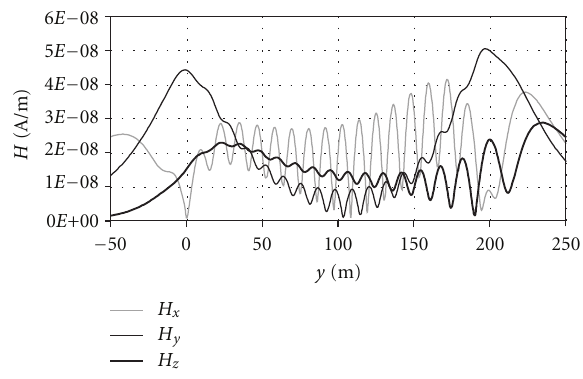
Figure 8: The current distribution along a simple PLC system.